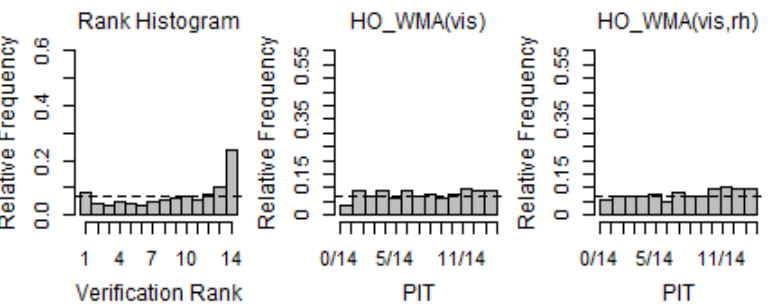
Figure 7. Verification rank histogram of raw ensemble forecasts and PIT histograms of WMA models for Station 110 (2019 MAM).